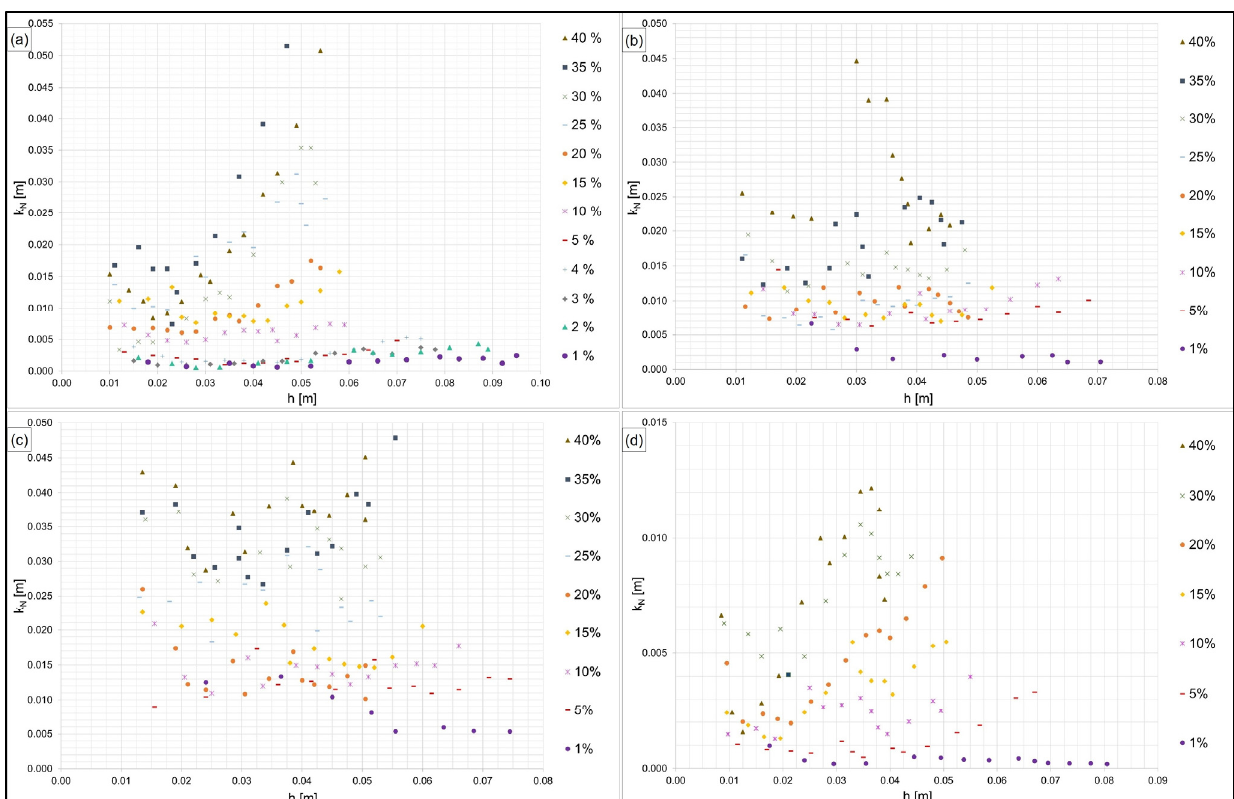
Figure 10. Relationship between water depth h and equivalent sand–grain roughness k N for measured values of ( a ) cement-based coating, ( b ) asphalt emulsion, ( c ) exposed aggregate concrete, and ( d ) aluminum. Table 2. Derived, mean k N values from experiments of this study and literature references.